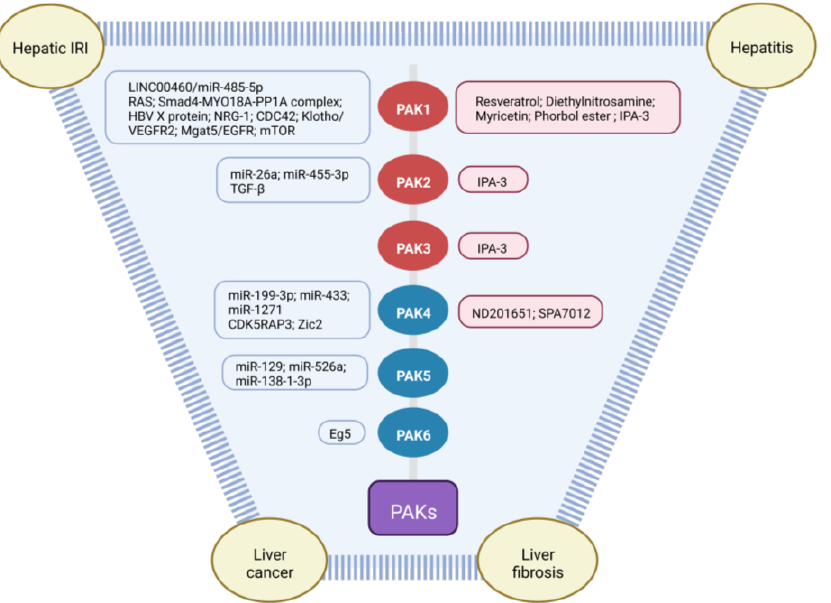
Figure 1. Upstream regulators of PAKs in liver disorders. The upstream regulators of PAKs in liver disorders include exogenous compounds and endogenous molecules (proteins, miRNAs and lncRNAs). CDK5RAP3, CDK5 kinase regulatory subunit-associated protein 3; IRI, ischemia-reperfusion injury; Mgat5, N-acetylglucosaminyltransferase V; PAK, p21 Activated Table 1. Overview of PAKs in liver disorders.